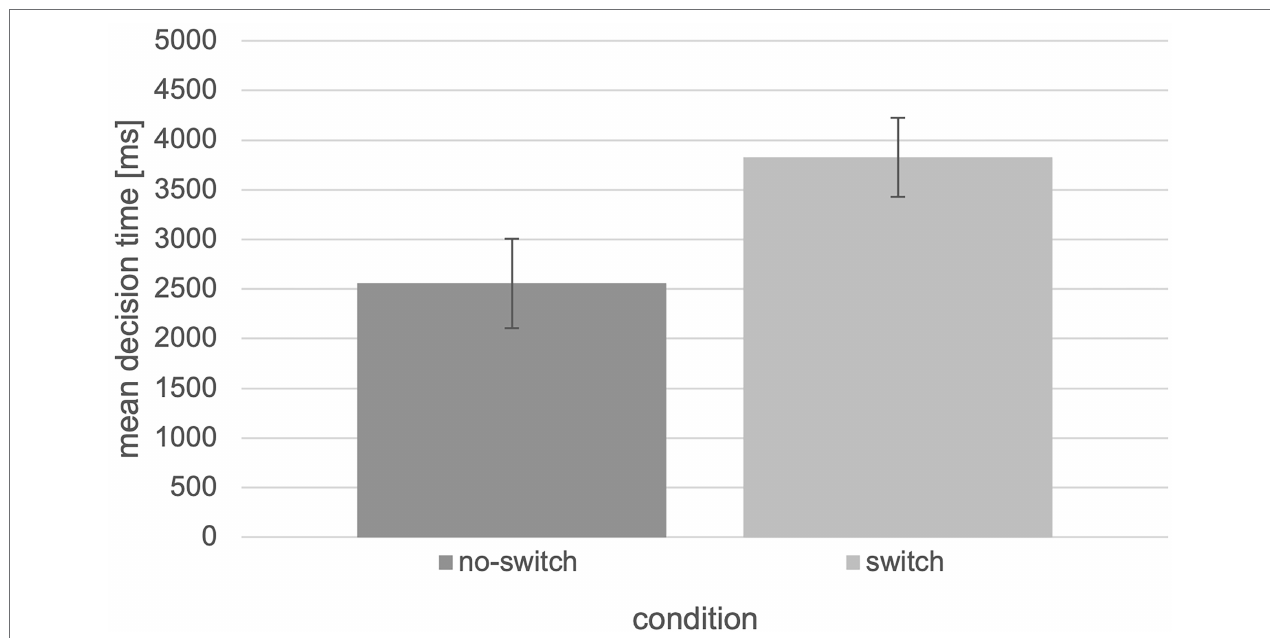
FIGURE 7 | Mean decision time in ms with respect to the “switch” and “no switch” condition of the tested experiment ( N = 30, error bars = SEM in